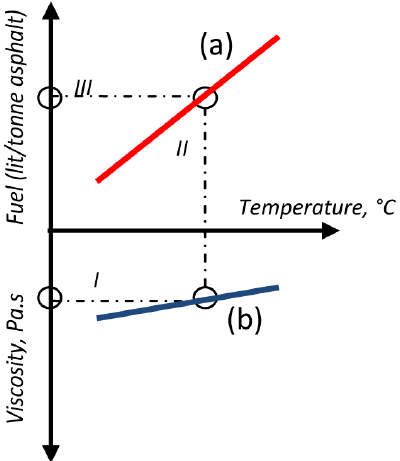
Fig. 2. Fuel reduction based on reduction in viscosity due to wax modification of the binder (Butt et al .